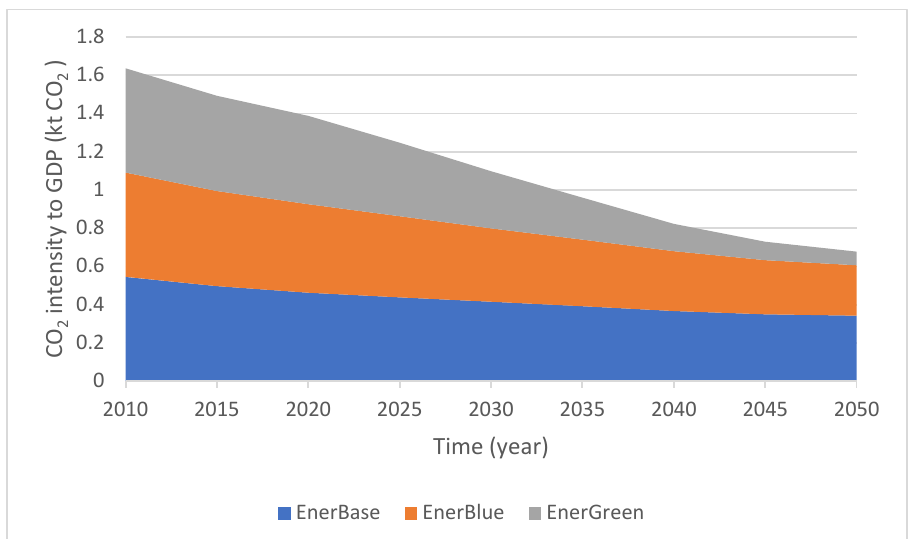
Figure 5. CO 2 intensity to GDP, kt CO 2 (kgCO 2 /$15, constant US$, purchasing power parities). Source: based on data from [30].